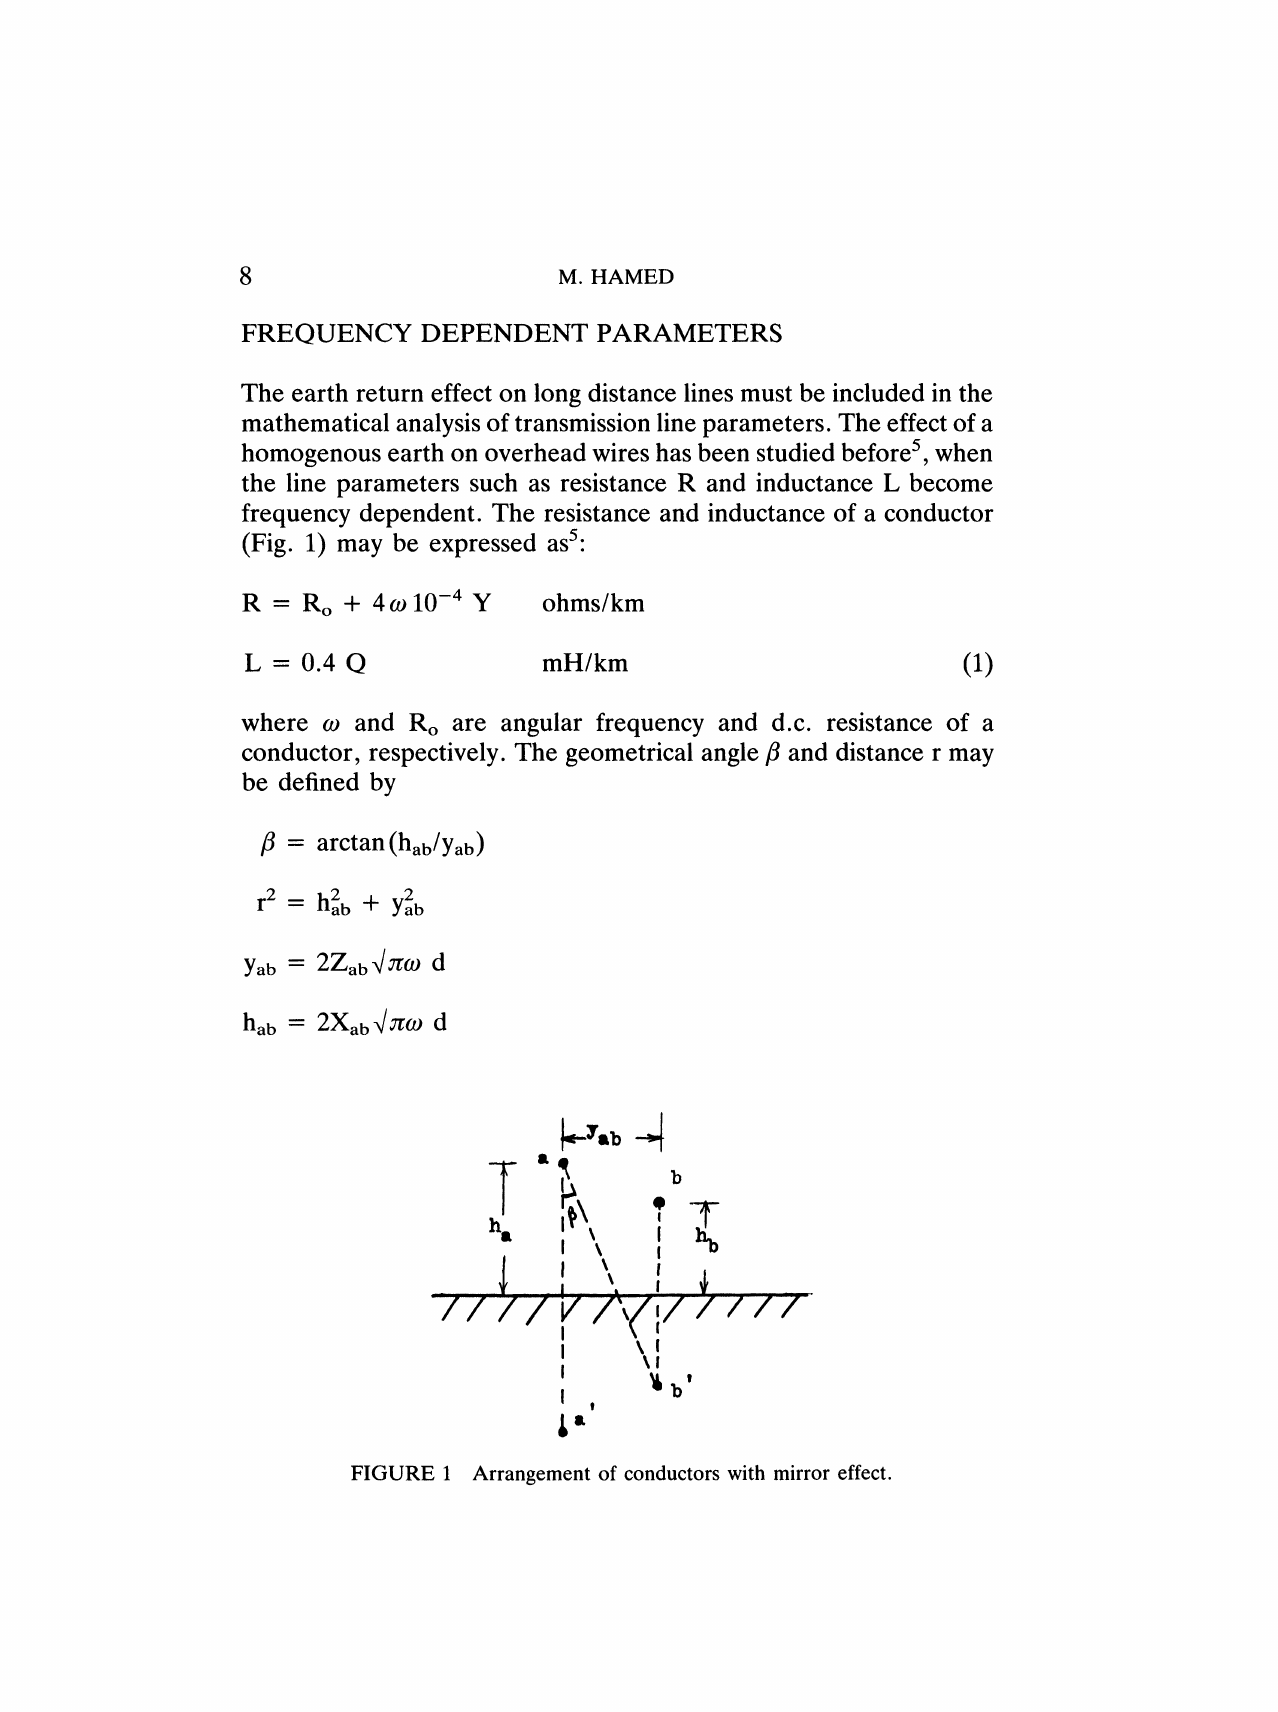
FIGURE Arrangement of conductors with mirror